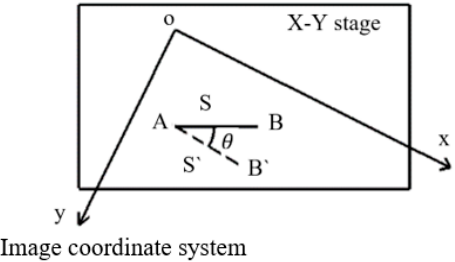
Figure 9. Schematic diagram of expected displacement and actual displacement. The expected vector displacement S is from point A to point B , but the actual displacement becomes vector S (cid:48) that is from point A to point B (cid:48) . The deflection angle between the expected displacement and actual displacement is θ